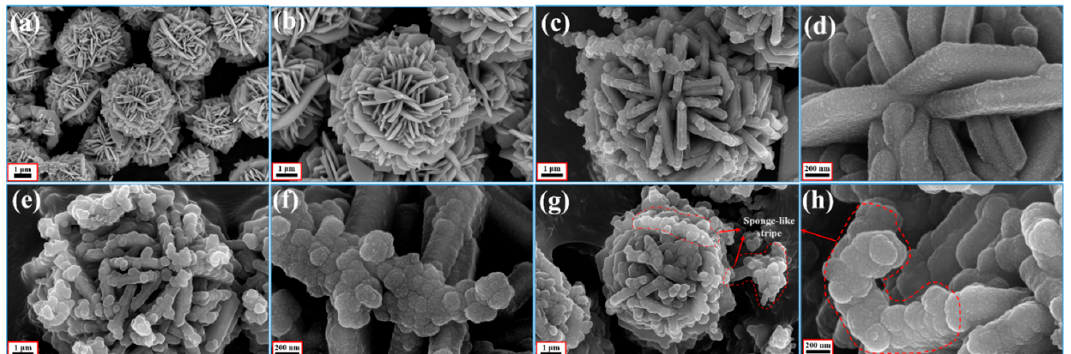
Figure 4. Different magnification SEM images of ( a , b ) hollow CuS, ( c , d ) Sample A, ( e , f ) Sample B, and ( g , h ) Sample C.